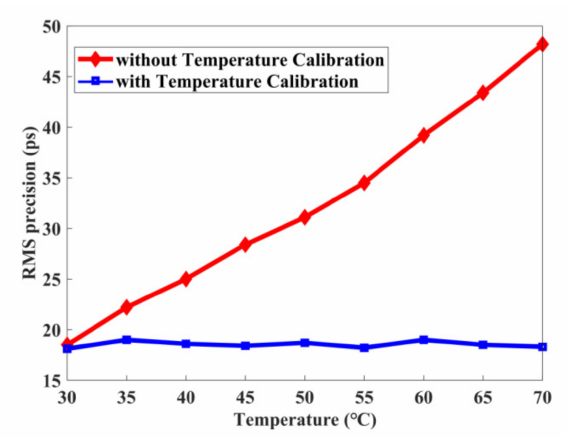
Figure 13. The TDC RMS precision under different temperatures with and without temperature